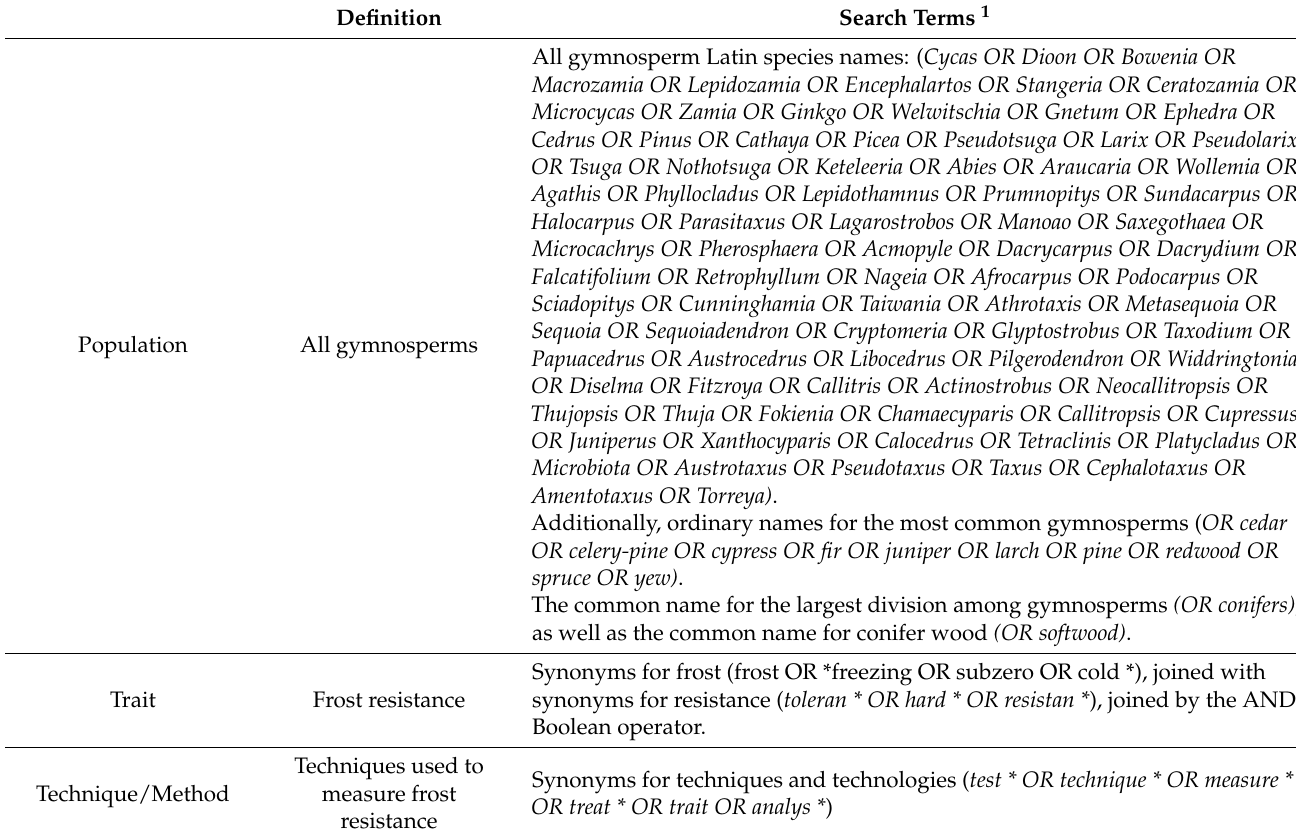
Table 1. Definition of the main components of the search and the search terms